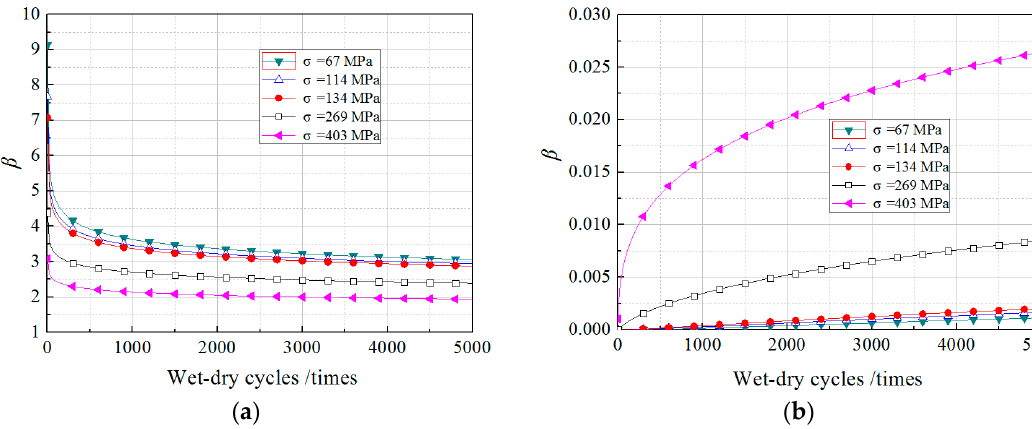
Figure 10. The effects of standard deviations of the load on the GFRP specimens: ( a ) Change of β with wet-dry cycles; and ( b ) change of P with wet-dry cycles.